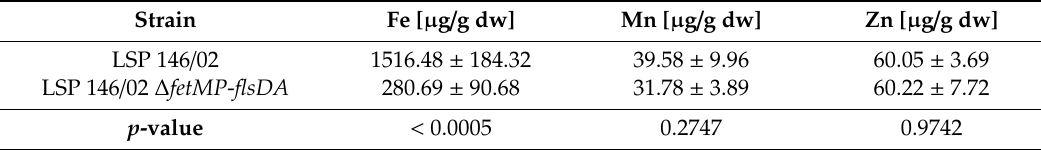
Table 1. Intracellular metal concentration in S. Typhimurium LSP 146 / 02 and its ∆ fetMP - flsAB mutant. Strain